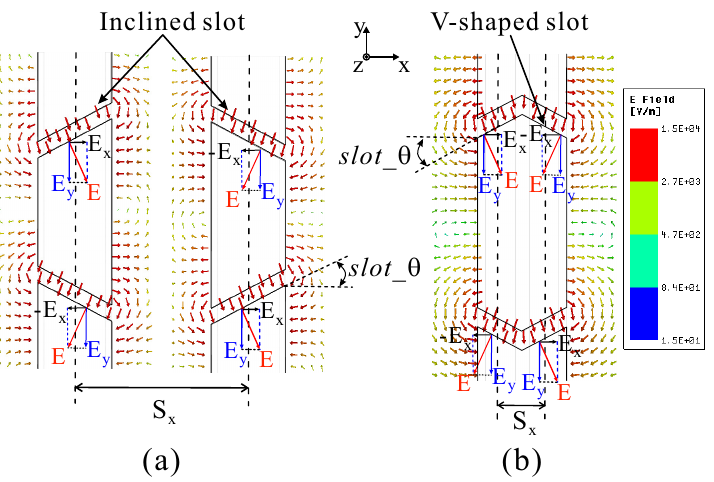
Figure 3. EM field surface distribution on a radiating waveguide of the two HP slots. ( a ) Inclined slot. ( b ) V-shaped